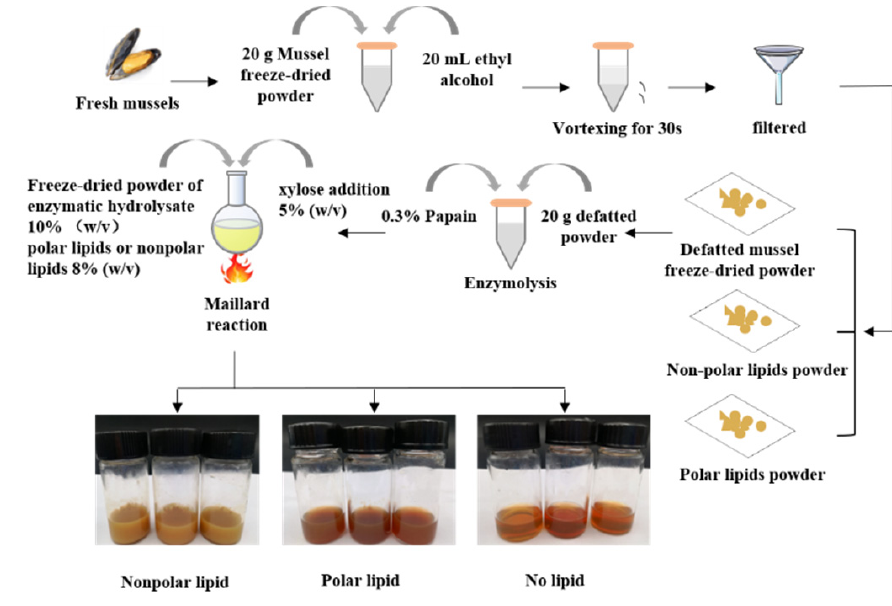
Figure 1. Preparation process of the mussel